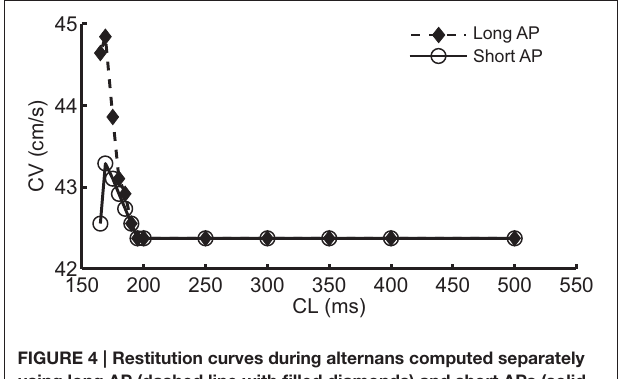
FIGURE 4 | Restitution curves during alternans computed separately using long AP (dashed line with filled diamonds) and short APs (solid line with open circles) during the dynamic protocol.